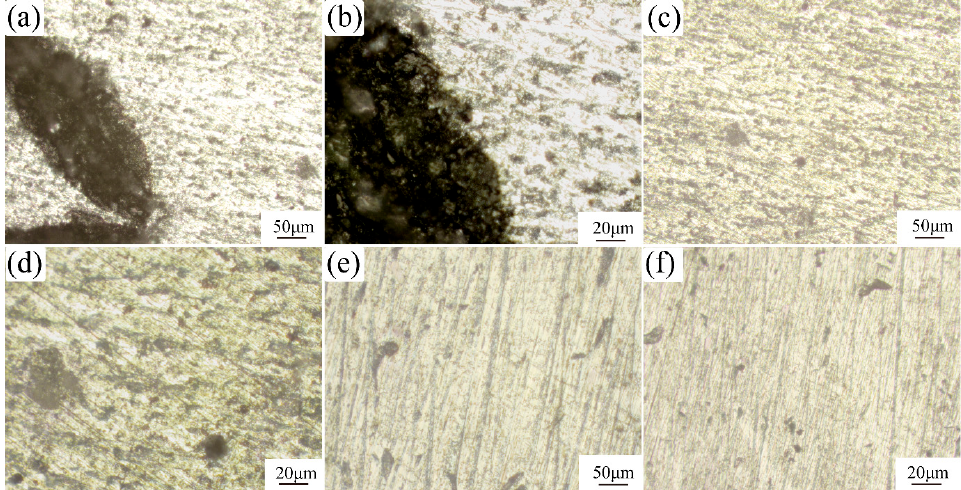
Figure 5. Optical micrographs of two materials after Tafel corrosion: ( a – d ) Al 2 O 3 3D/5083Al; ( e – f ) 5083 Al.